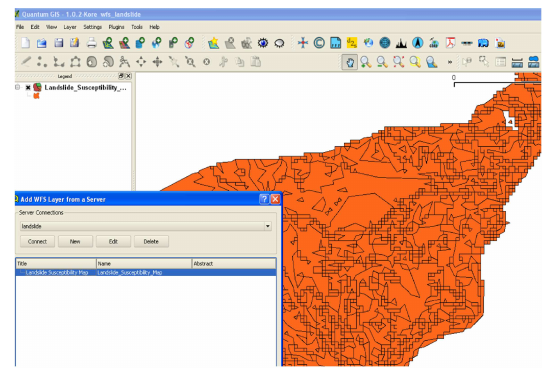
Figure 8. WFS service of Landslide susceptibility dataset consumed by open source Quantum GIS